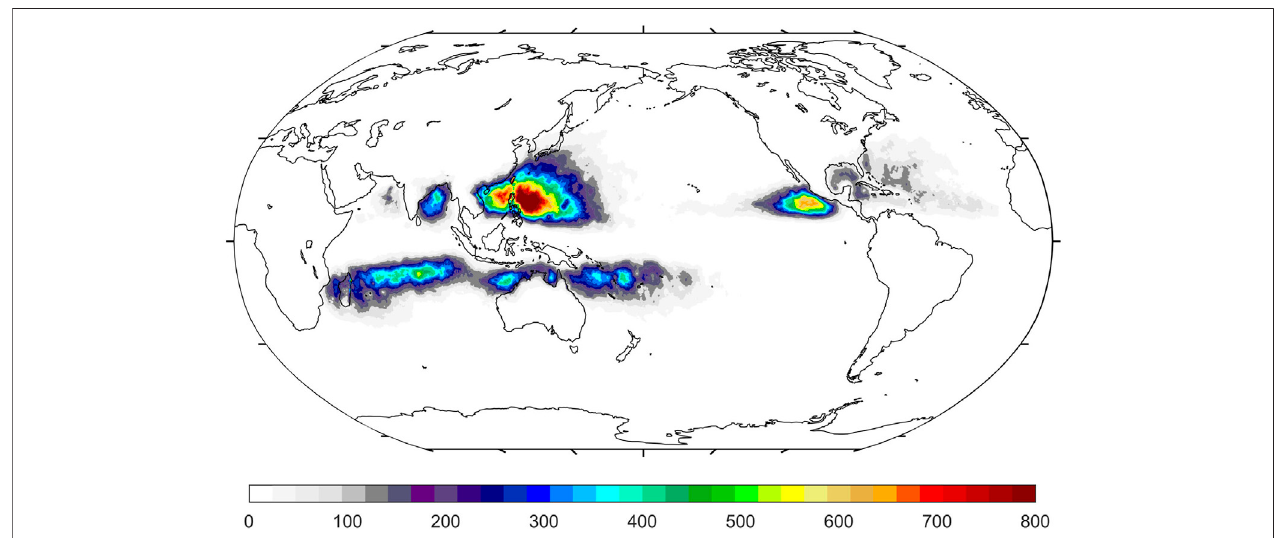
FIGURE 3 | Annual average tropical cyclone precipitation (unit: mm/year) in observations based on the International Best Track Archive for Climate Stewardship (IBTrACS; Knapp et al., 2010) dataset and the Multi-Source Weighted-Ensemble Precipitation Version 2 (MSWEP v2, Beck et al., 2017a; 2017b) precipitation data.